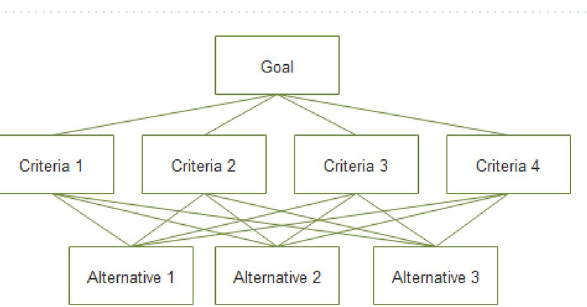
Figure 1. The location of the Zayandeh-Rud basin in Iran.